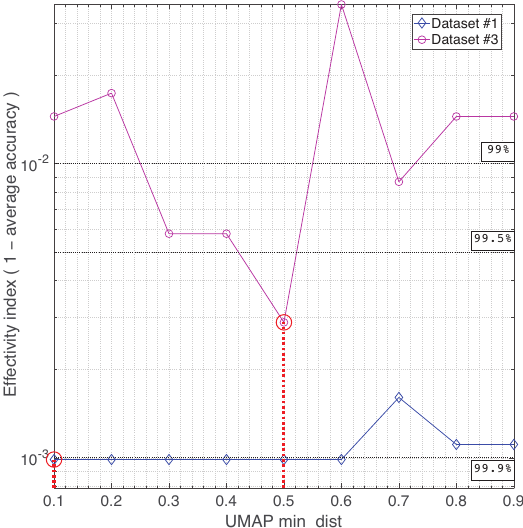
Figure 11. Average accuracy versus the minimum distance between points in the low-dimensional UMAP representation min_dist for datasets #1 and #3 (semi-logarithmic plot in the vertical axis). The vertical axis represents the effectivity index. The optimal selected parameters are highlighted in red. The accuracy range for dataset #1 is from 99.839% to 99.901% and for dataset #3 is from 96.536% to